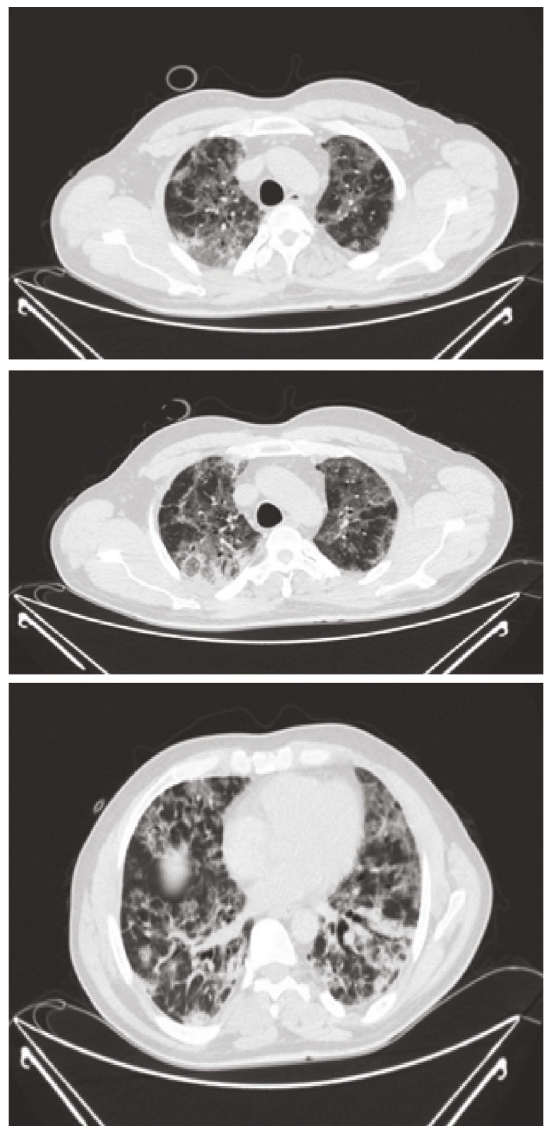
Figure 2: Chest CT shows pathology typical for